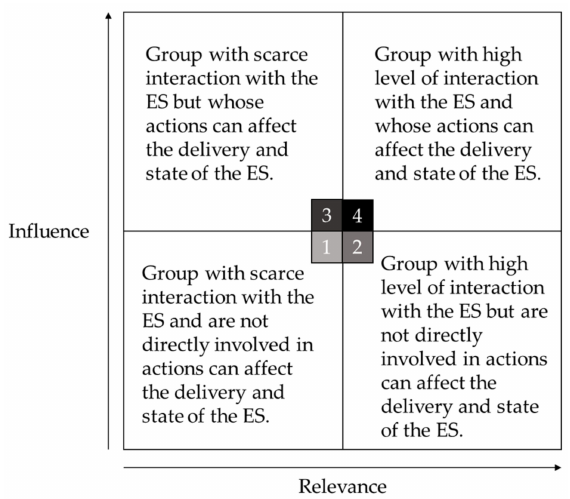
Figure 2. Different typologies of the stakeholder groups based on their relevance and influence over the ES (Adapted and modified from Figure 3 in